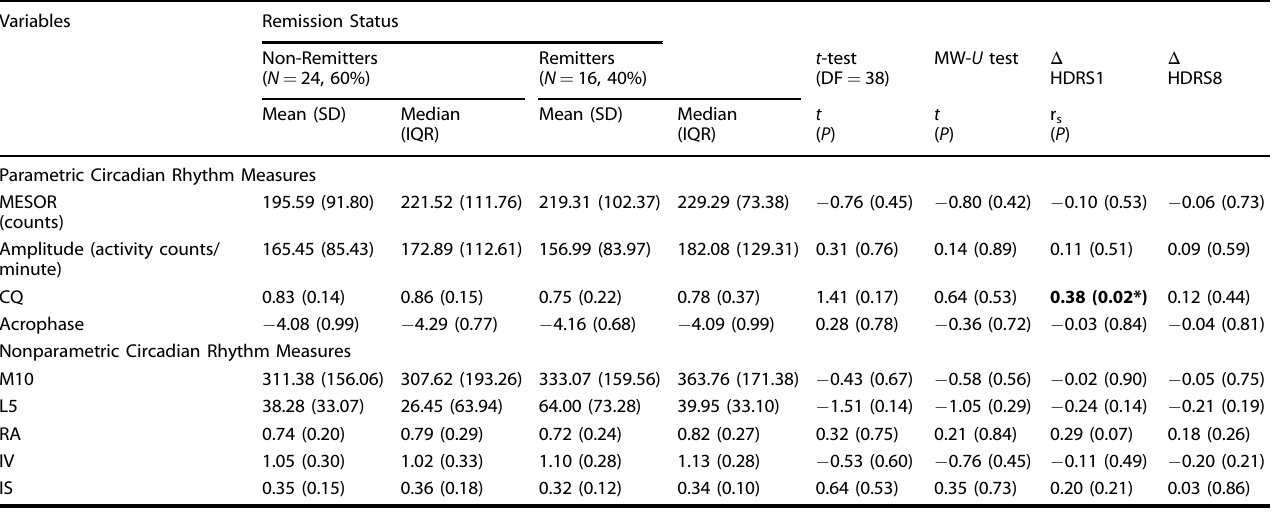
Table 2. Participants ’ circadian rhythm measures, collected during fi rst week of treatment, strati fi ed by remission status and their relation to change in